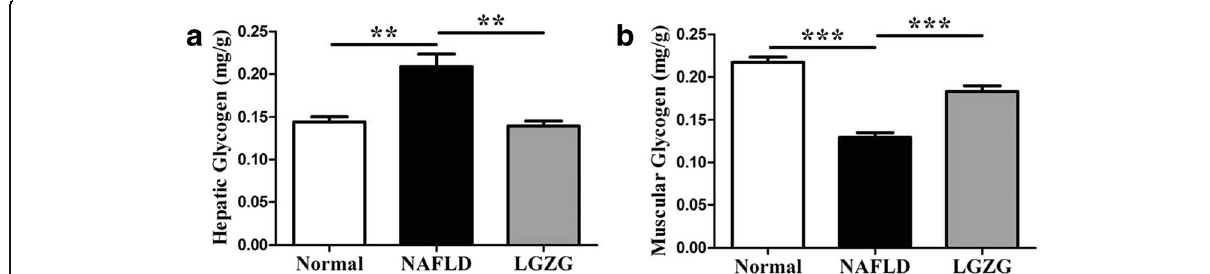
Fig. 4 LGZG reduced hepatic glycogen in NAFLD rats. a The level of hepatic glycogen, ( b ) The level of muscle glycogen. Data were presented as means ± SEM ( n = 8 per group). ** P < 0.01, *** P < 0.001